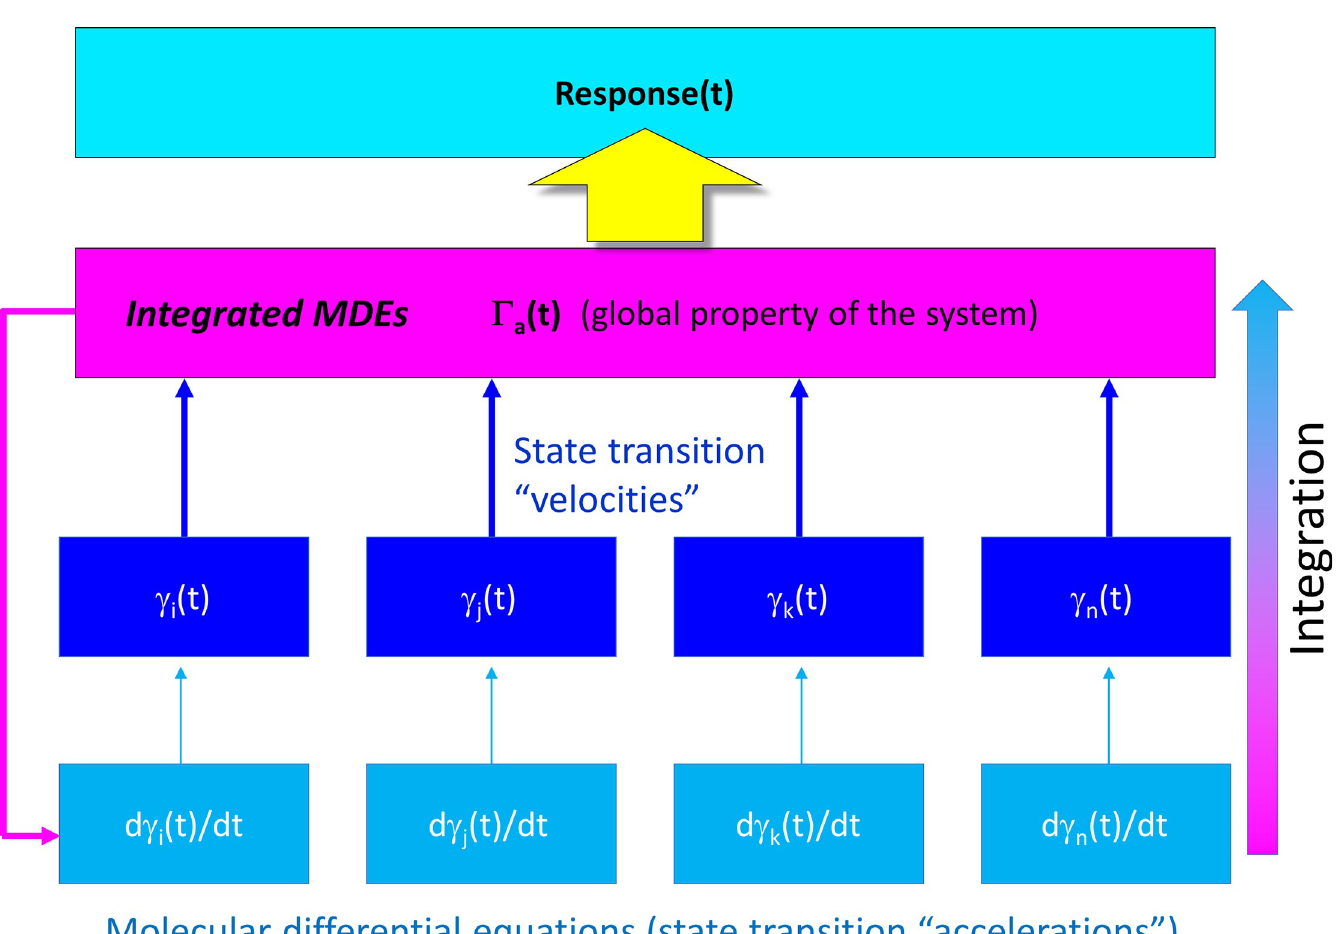
Fig 2. Cellular analog computing is based on the transduction of molecular state transitions into cellular function. MDEs { d γ aggregate for the corresponding time-dependent state occupancies of the participating species { d γ k ( t )/ dt , k = 1, n } (e.g. dynamic intra- and intermolecular states), together with higher order properties that we refer to as Γ response